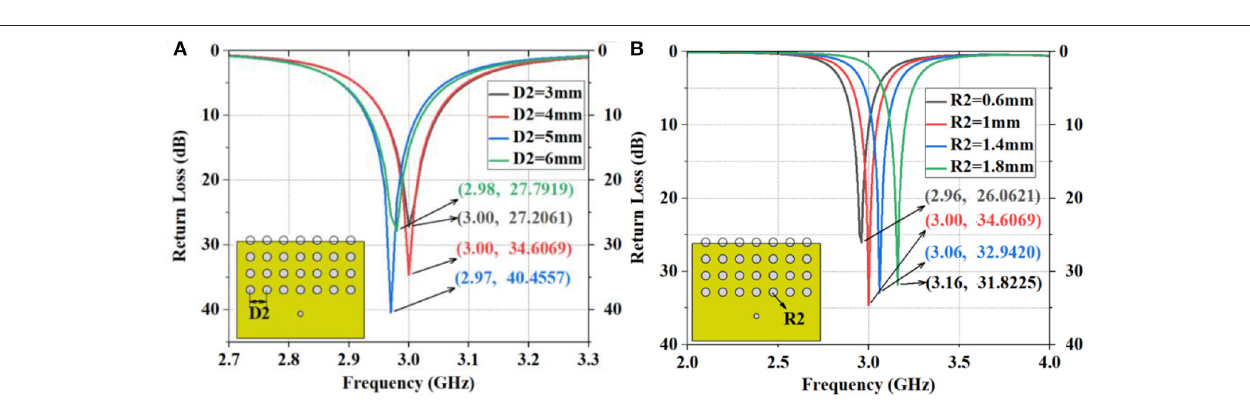
FIGURE 6 | The simulation of return loss of the antenna with four lines of drilled holes. (A) The different dimensions of R2, (B) The different dimensions of D2.